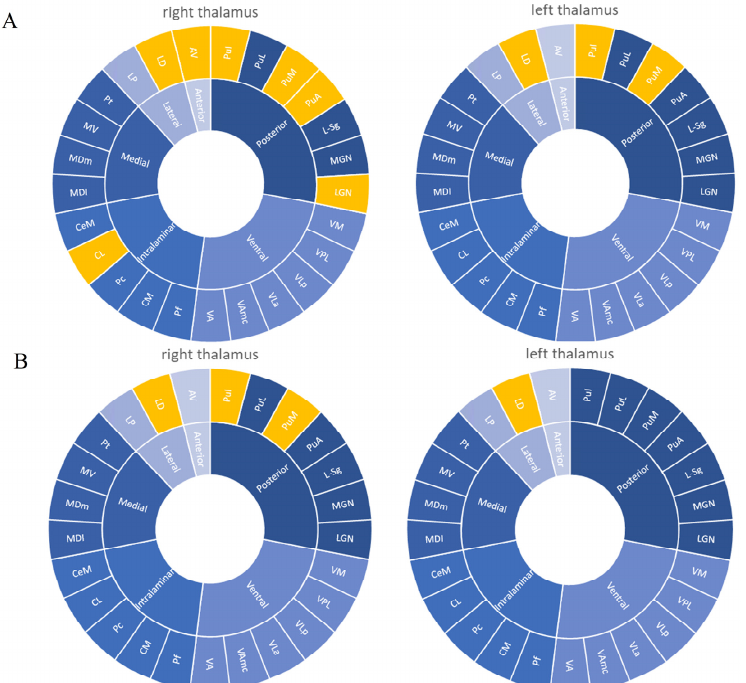
Figure 2. Significant differences of volume changes in individual thalamic nuclei according to presence or absence of fatigue symptom in the patients. ( A ) F-MS vs. HC results. ( B ) NF-MS vs. HC results. Yellow regions indicate decreased volumes in PwMS compared to HCs. In the F-MS group, the right anteroventral, bilateral laterodorsal, right central lateral, right lateral geniculate, right pulvinar anterior, bilateral pulvinar medial, and bilateral pulvinar inferior nuclei volumes were decreased compared to that of the HCs ( A ). In the NF-MS group, the bilateral laterodorsal, right pulvinar medial, and right pulvinar inferior nuclei volumes were decreased compared to that of the HCs ( B ). AV: Anteroventral, LD: laterodorsal, LP: lateral posterior, VA: ventral anterior, VAmc: ventral anterior magnocellular, VLa: ventral lateral anterior, VLp: ventral lateral posterior, VPL: